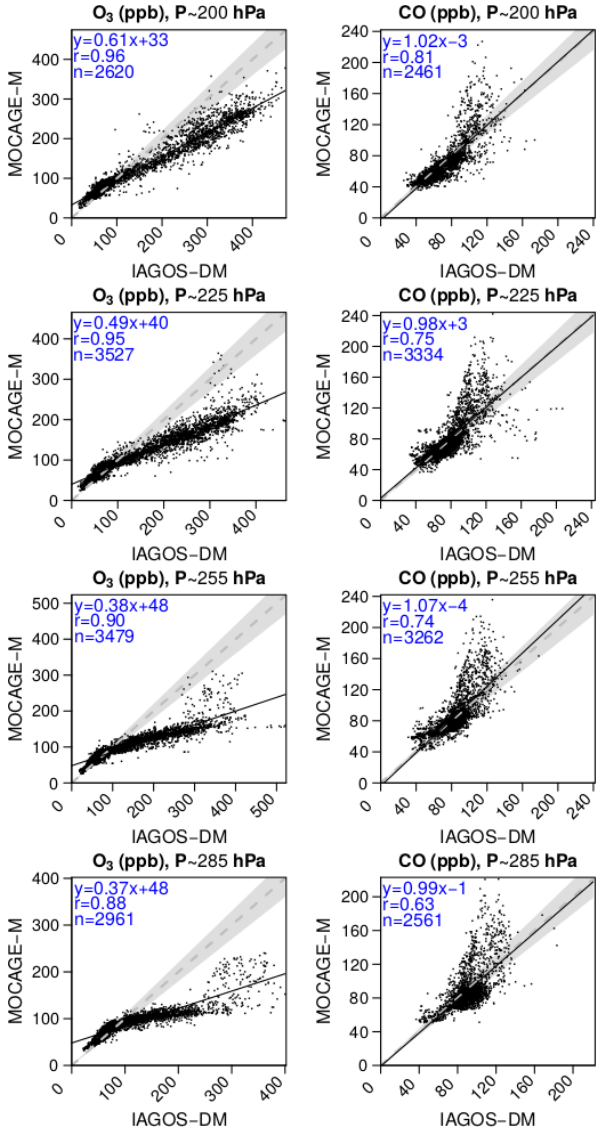
Figure B4. As Fig. 5 for boreal